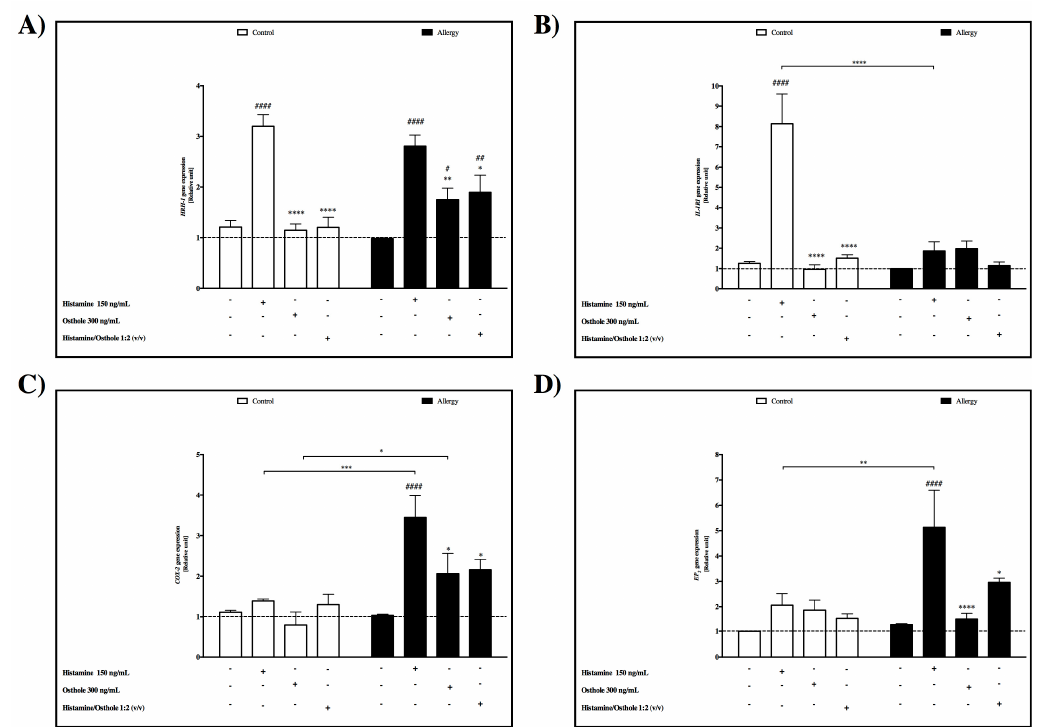
Figure 2. Comparison of mRNA gene expression changes in control and allergy group PBMCs under the influence of histamine, osthole, and histamine/osthole between the control and allergy group. ( A ) HRH-1 receptor, ( B ) IL-1RI receptor, ( C ) COX-2, and ( D ) EP 2 . The control is gene expression in native cells, presented as 1. Statistically significant differences between the control and tested sample are directly above the error bar: **** p <